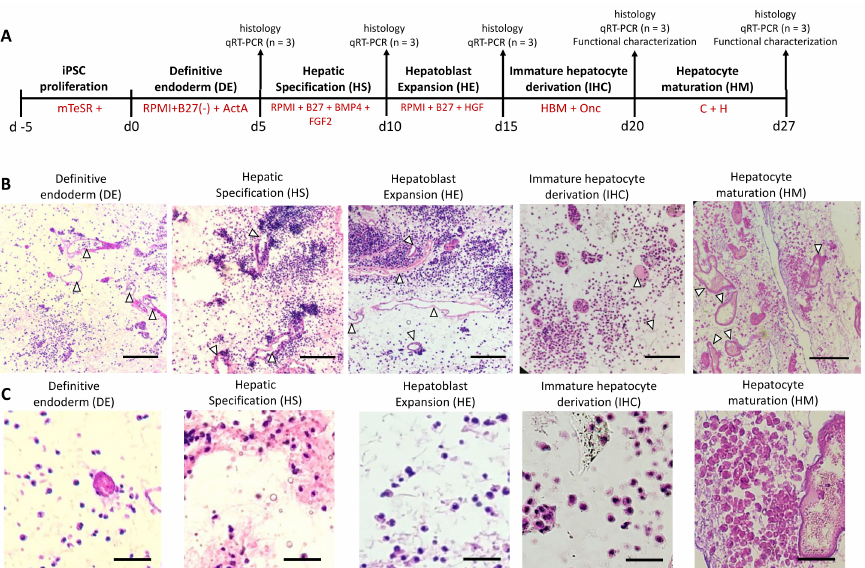
Figure 1. The perfusion differentiation of iPSCs to hepatocyte-like cells in rat livers. ( A ) The differen- tiation protocol and timeline showing the different analyses performed at each stage of differentiation. ( B ) Histological analysis of decellularized rat livers recellularized with iPSCs throughout the differ- entiation through H&E staining. White triangles show that vessels in the rat liver remained open following perfusion seeding and differentiation. (Scale bars = 200 µ m.) ( C ) High magnification histo- logical images showing cell morphology at different stages of differentiation. (Scale bars = 50 µ